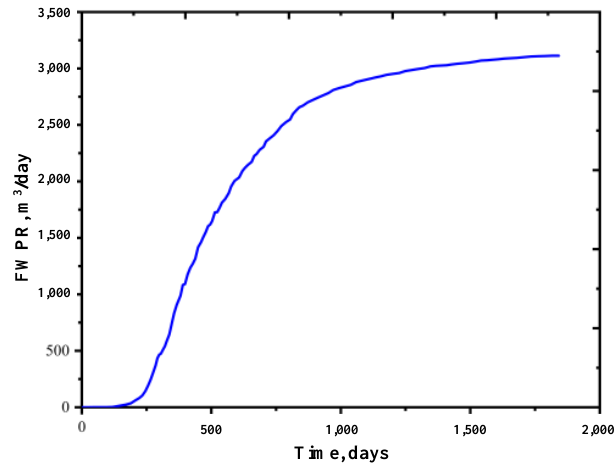
Figure 10. Field water production rate for horizontal wells.